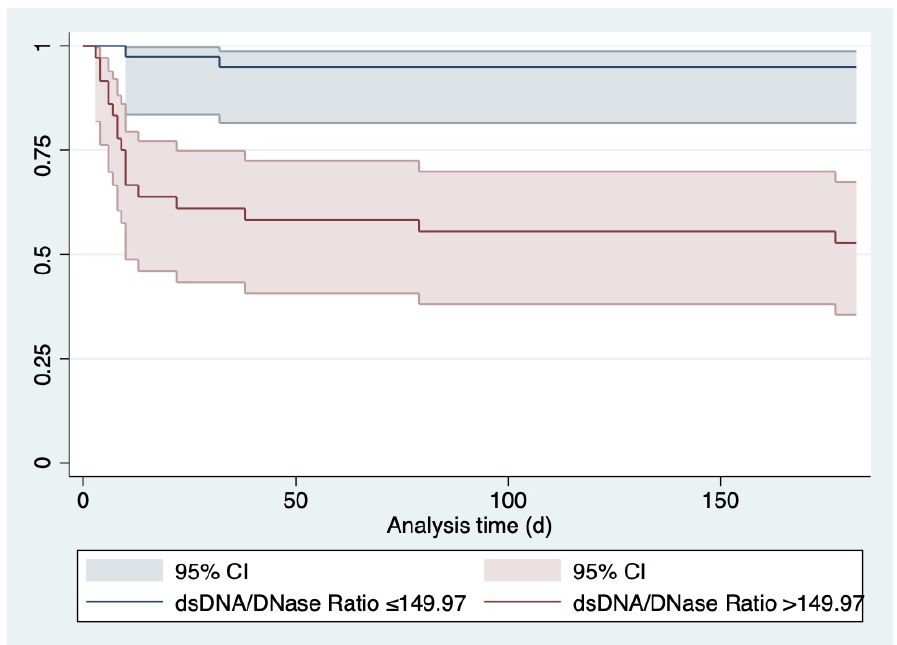
Figure 4. Kaplan –Meier plot for patients with dsDNA/DNase Ratio ≤ 149.97 versus dsDNA/DNase Ratio > 149.97. 96 h after ICU admission. Abbreviations: CI: confidence interval; ICU: intensive care unit.